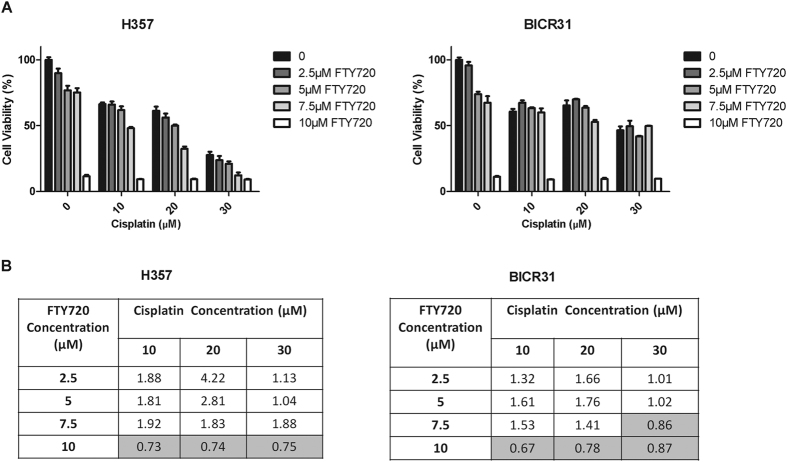
Combined effects of FTY720 and Cisplatin.(A) H357 and BICR31 cells were treated with various concentrations of FTY720 and Cisplatin in complete media for 72 hours prior to MTT assay. Graphs represent three independent experiments performed in triplicates. Percentage of cell viability is expressed relative to cells treated with medium containing diluent (DMSO) alone. (B) Combination index (CI) between FTY720 and Cisplatin was computed and the CI values obtained for each drug combination are shown in the table. Combinations with CI values lower than 1 (synergism) are highlighted in grey.